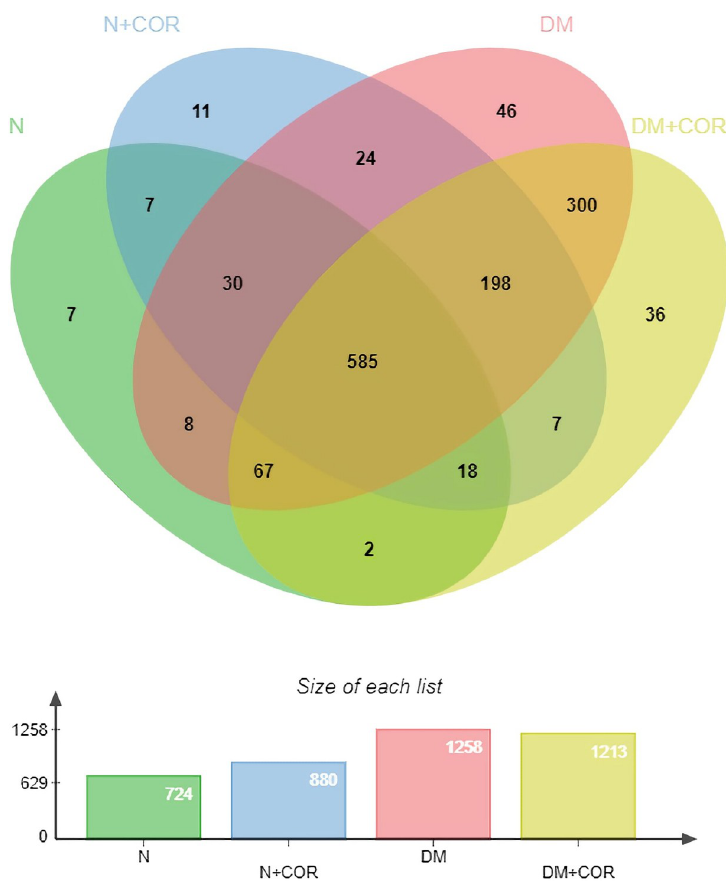
Fig 4. Venn diagram of proteins differentially expressed in the normal control group (N), normal mice treated with cordycepin (N+Cor), diabetic control group (DM), and diabetic mice treated with cordycepin (DM+Cor).